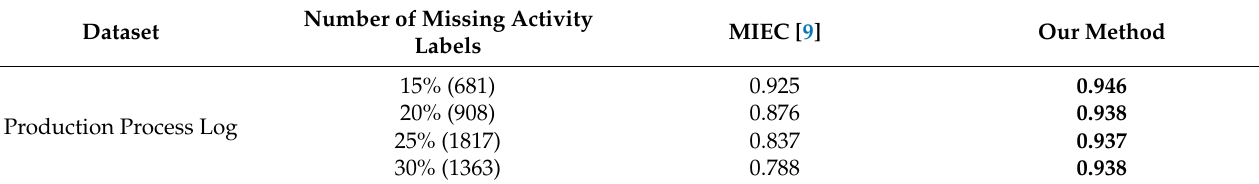
Table 7. Comparison of our method with the MIEC [9].